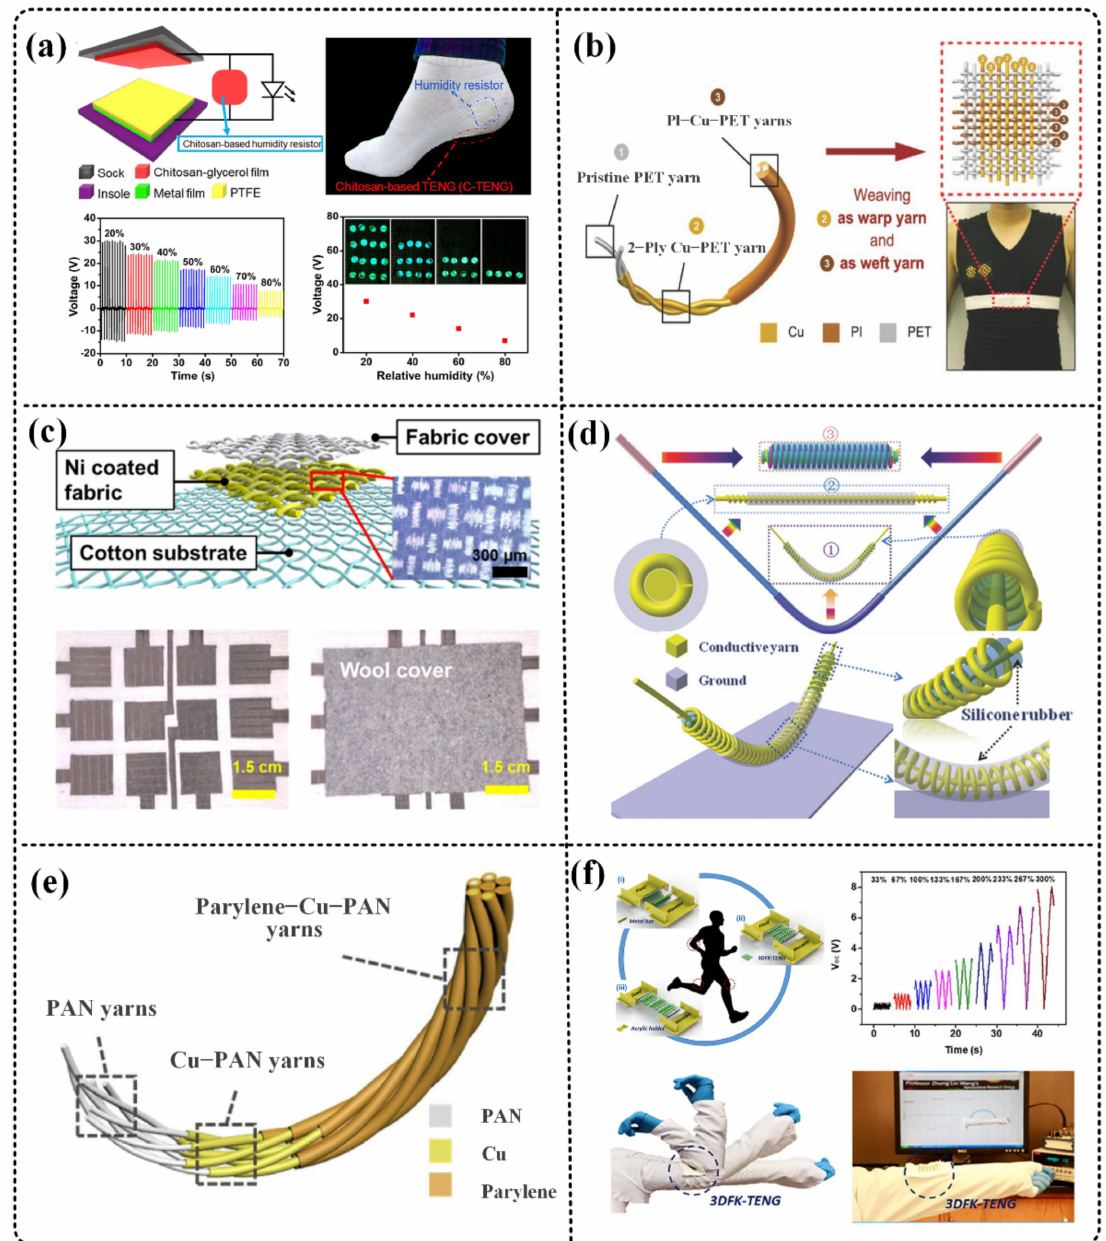
Figure 5. T-TENG acts as active sensors. ( a ) Jao et al. developed a TENG based on chitosan, which has different voltage outputs under different humidity environments. Reproduced with permission from Elsevier (2018) [24]. ( b ) Zhao et al. designed a T-TENG based on polyethylene terephthalate (PET) and copper Cu to monitor human respiratory rate and depth. Reproduced with permission from Wiley (2016) [25]. ( c ) Jeon et al. designed a TENG-based wearable fabric keyboard completely using commercial fabric. Reproduced with permission from Elsevier (2018) [28]. ( d ) Dong et al. designed a coaxial spring-like spiral-wound structure of TENG as a skipping rope counter. Reproduced with permission from Wiley (2018) [29]. ( e ) Zhao et al. covered the polyacrylonitrile yarn with copper (Cu) and parylene to obtain a composite yarn, which was then woven into TENG pressure sensors with different structures. Reproduced with permission from Elsevier (2020) [30]. ( f ) The 3D double-sided interlocking fabric TENG designed by Chen et al. can be used for tensile testing. Reproduced with permission from Elsevier (2020)